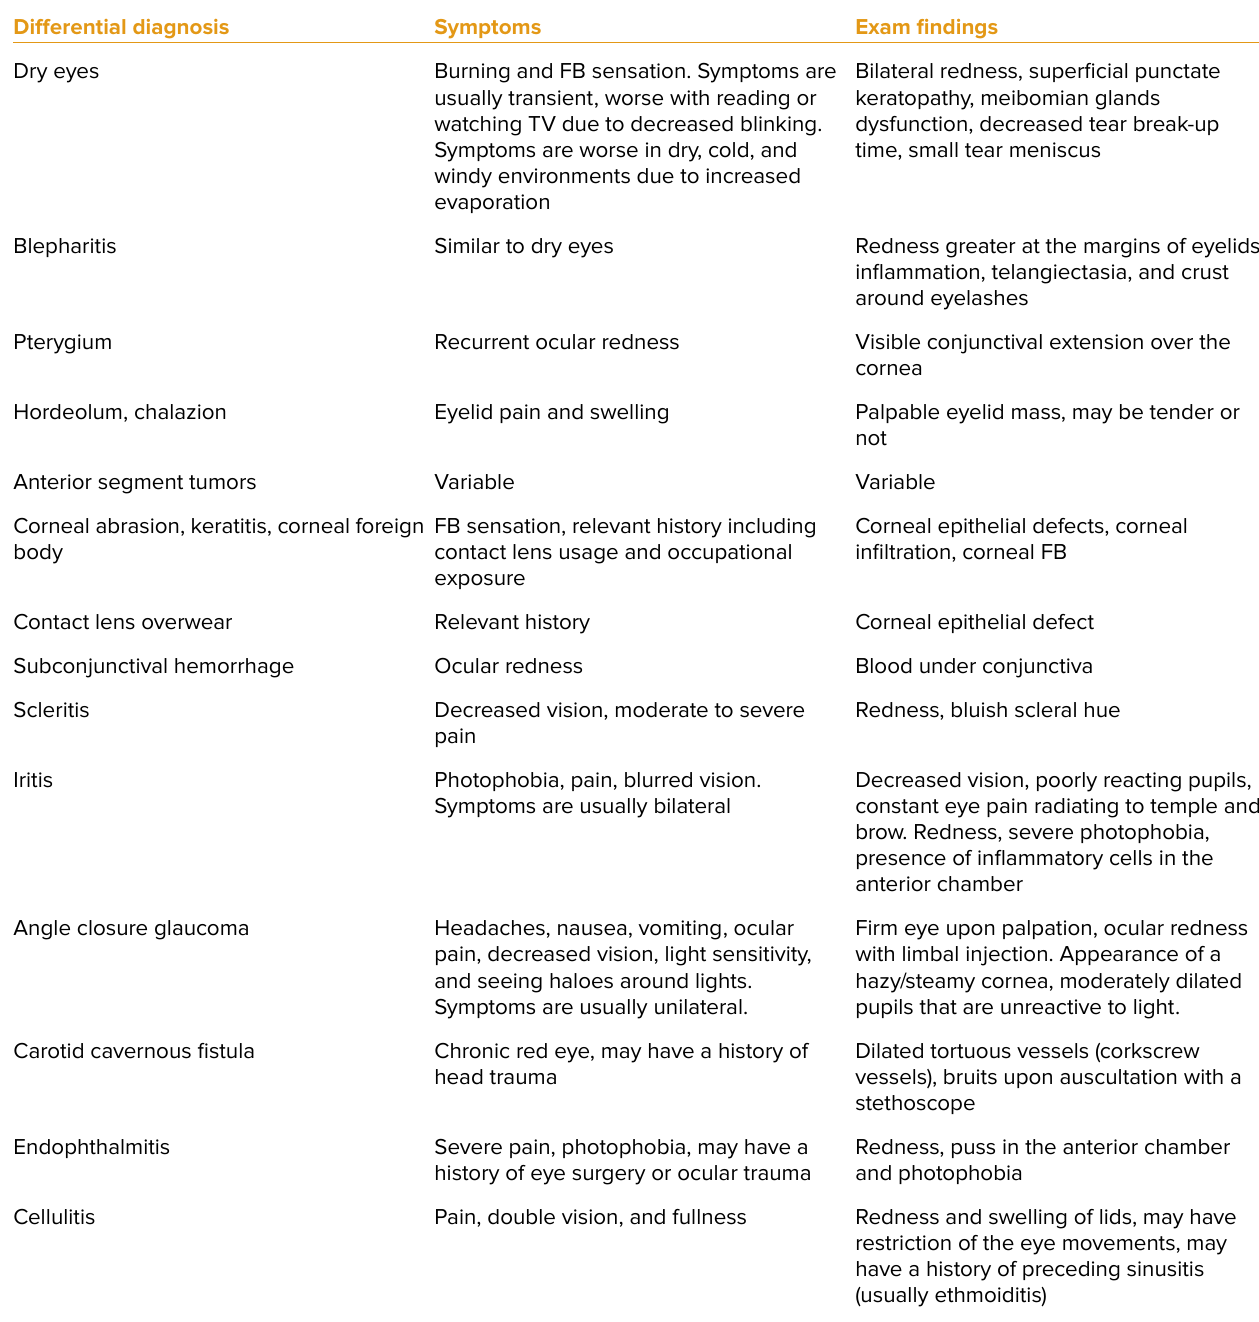
Table 2. Selected non-conjunctivitis etiologies of red eye Differential